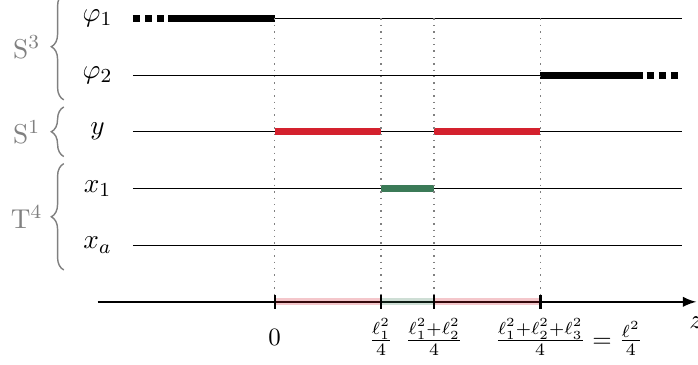
Figure 6 . Rod diagram of the shrinking directions on the z -axis after sourcing the solutions with three connected rods that force the degeneracy of the y and x